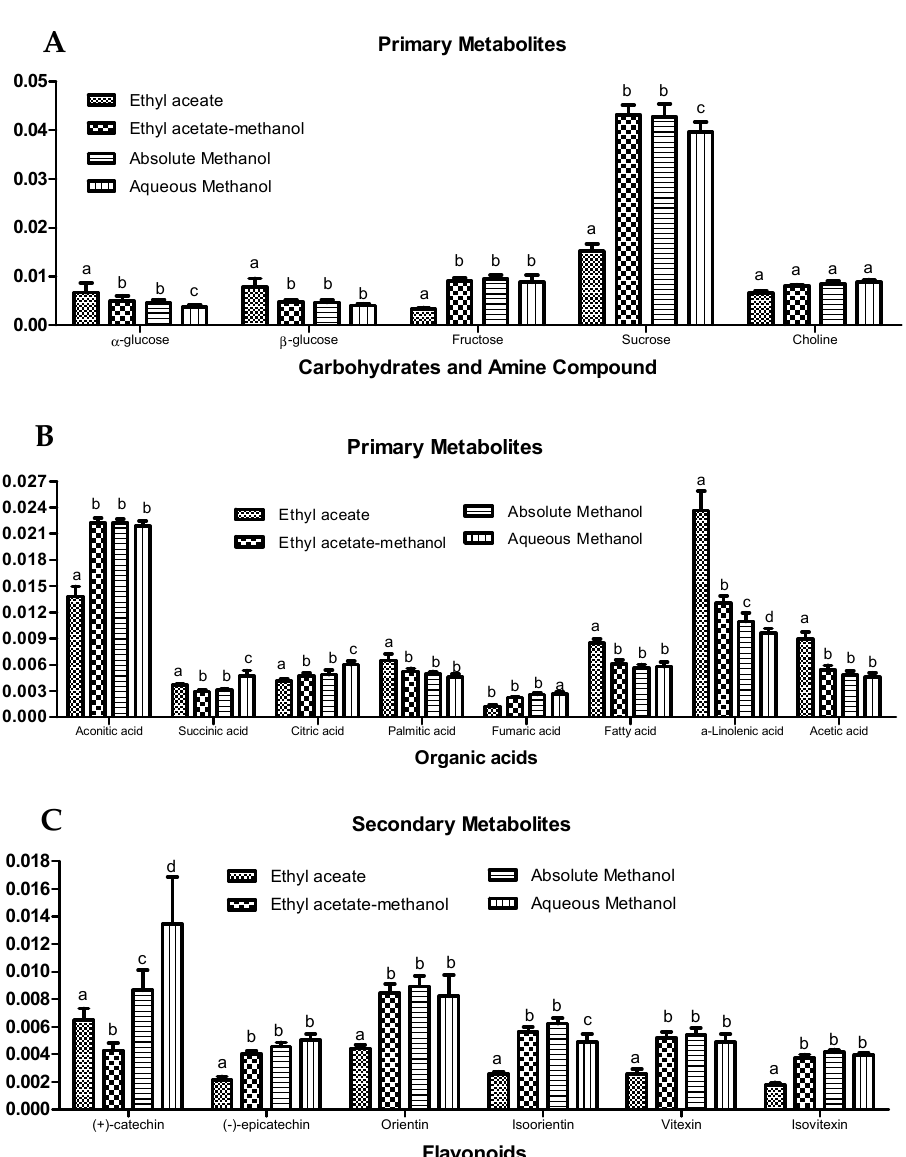
Figure 4. Relative quantification of identified compounds in different solvent extracts of OPL based on the mean peak areas of selected 1 H-NMR signals. ( A ) Carbohydrates and amines; ( B ) organic acids; ( C ) flavonoids. The discriminating chemical shifts (ppm) employed for the relative quantification were sucrose ( δ 3.82), fructose ( δ 4.18), α -glucose ( δ 5.18), β -glucose ( δ 4.62), choline ( δ 3.20), citric acid ( δ 2.74), succinic acid ( δ 2.54), aconitic acid ( δ 3.42), α -linolenic acid ( δ 1.30), acetic acid ( δ 2.07), palmitic acid ( δ 0.9), fatty acid ( δ 1.34), (+)-catechin ( δ 7.02), ( − )-epicatechin ( δ 6.94), orientin ( δ 7.54), isoorientin ( δ 7.40), vitexin ( δ 8.02), and isovitexin ( δ 7.79). Bars labelled with the different letters (a,b,c,d) are significantly different between solvent extracts for the same metabolites ( p < 0.05).